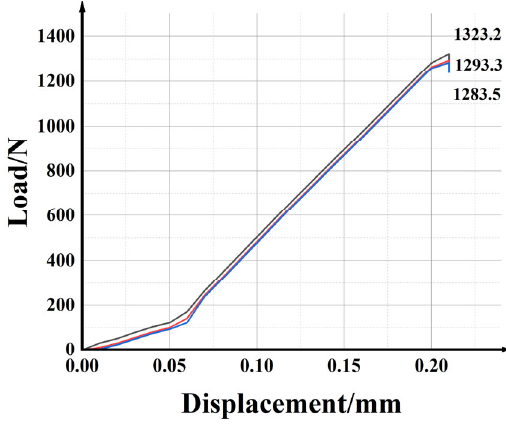
Figure 8. Strain–stress curves for the joint during shear tests.